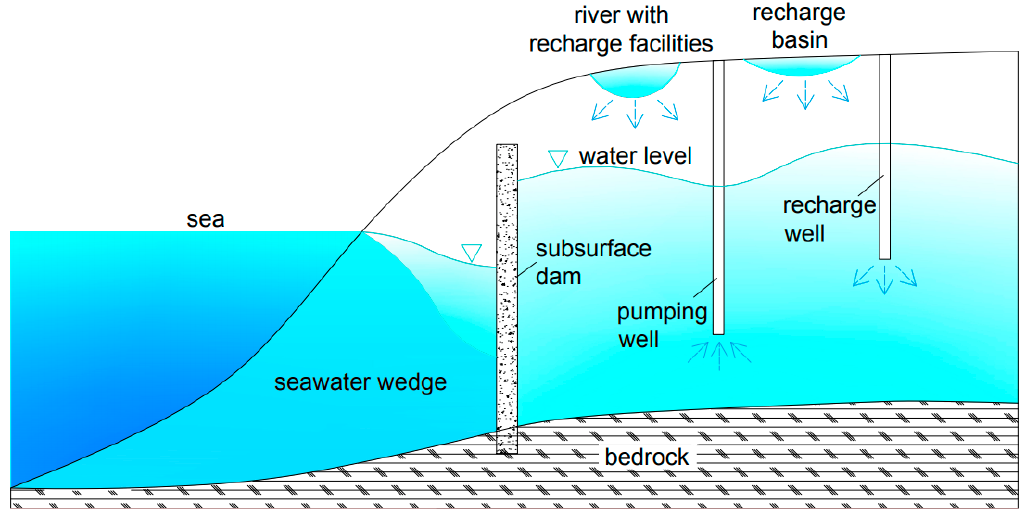
Figure 4 . A sketch map of the subsurface dam. Figure 4. A sketch map of the subsurface